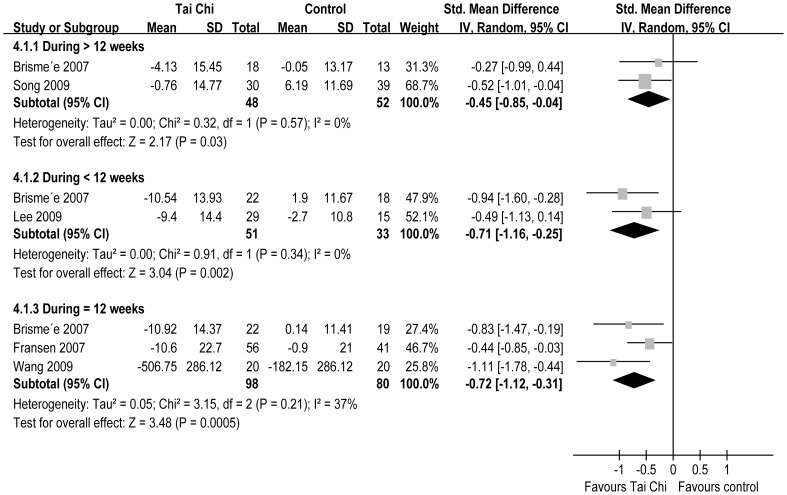
A Forest plot of the subgroup analyses of RCTs comparing Tai Chi group with control group for change in physical function.